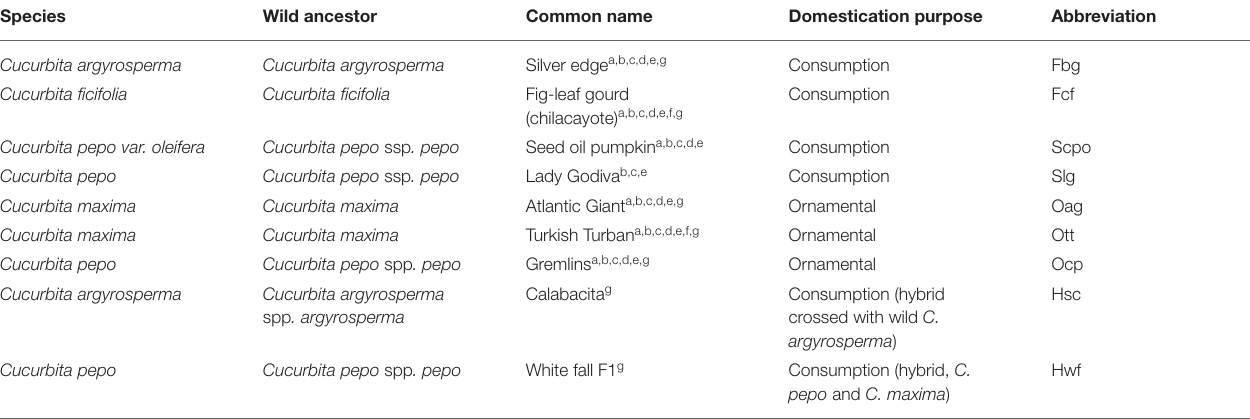
TABLE 1 | Summary of the Cucurbita species used for the experiment. Species